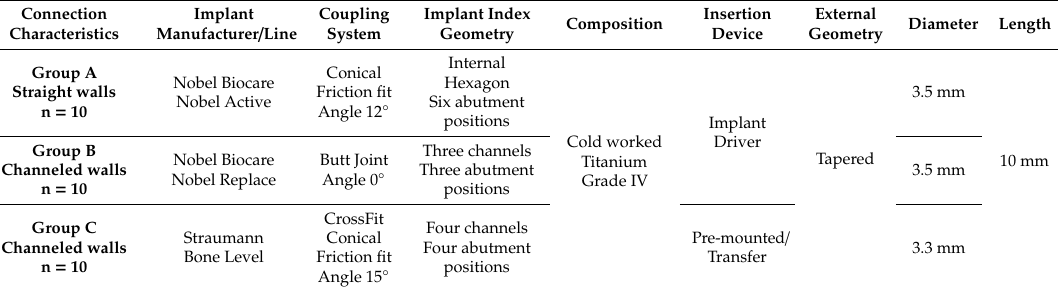
Table 1. Characteristics of the three narrow implant designs used for this in vitro experiment. Implant geometry, dimensions, characteristics of the connection, and composition are